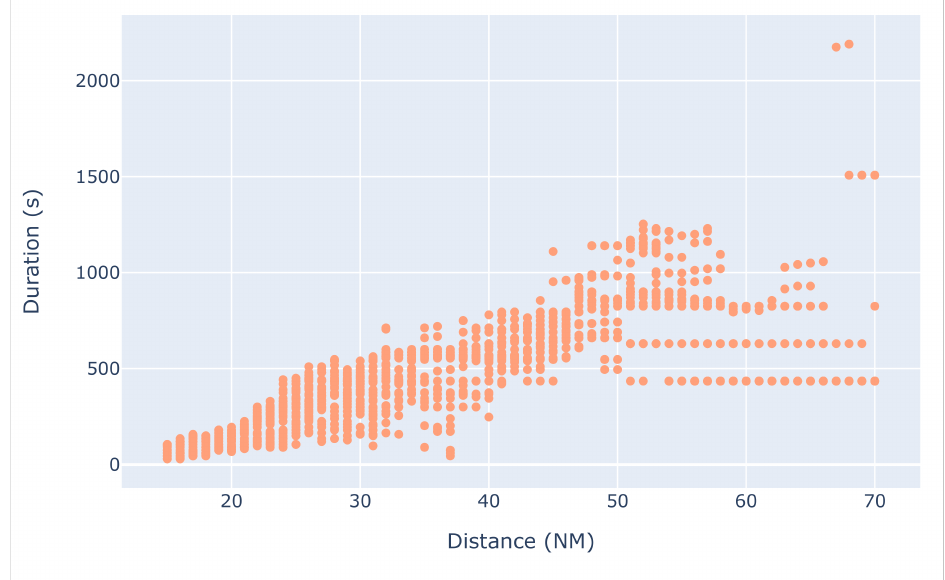
Figure 28. Duration of communities for different distance